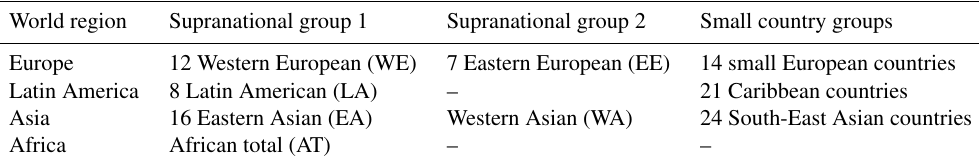
Table 2. Overview of the world region-specific supranational country groups and the small country groups that lack national resolution, as used within the Maddison Project